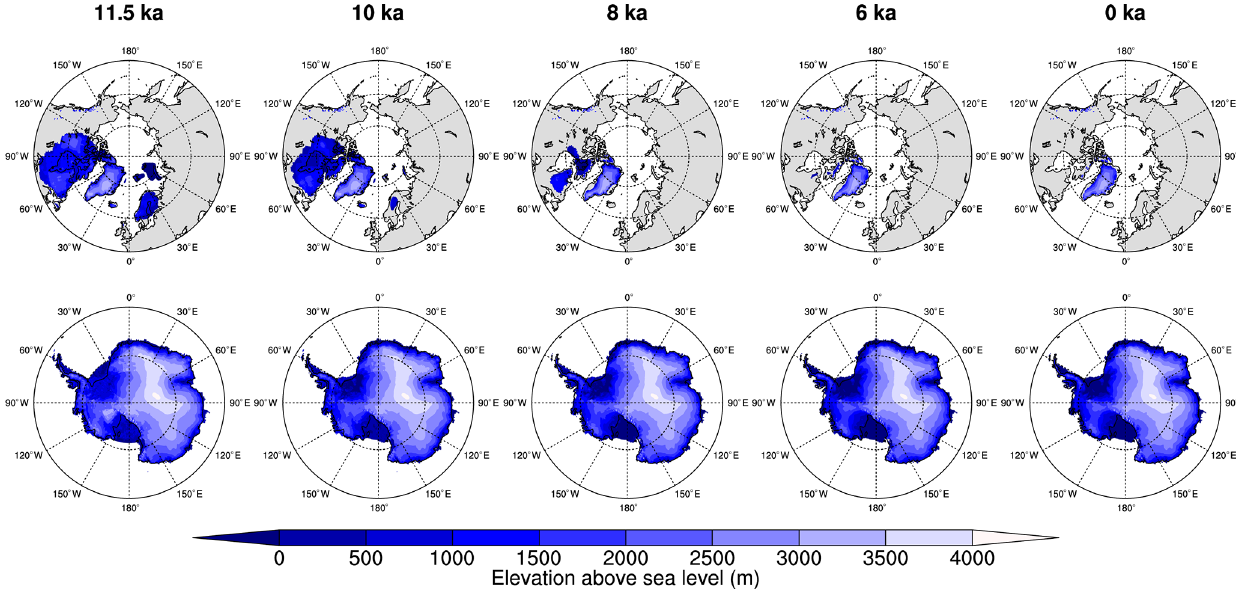
Figure 3. Northern Hemisphere (top) and Southern Hemisphere (bottom) ice sheet elevation at 11.5, 10, 8, 6, and 0ka (1950) for the ICE- 6G_C reconstruction at 10arcmin horizontal resolution; elevation is plotted where the fractional ice mask is more than 0.5 (Peltier et al., 2015). Table 2. Boundary conditions for the HT-11.5ka experiments. Orbital parameters